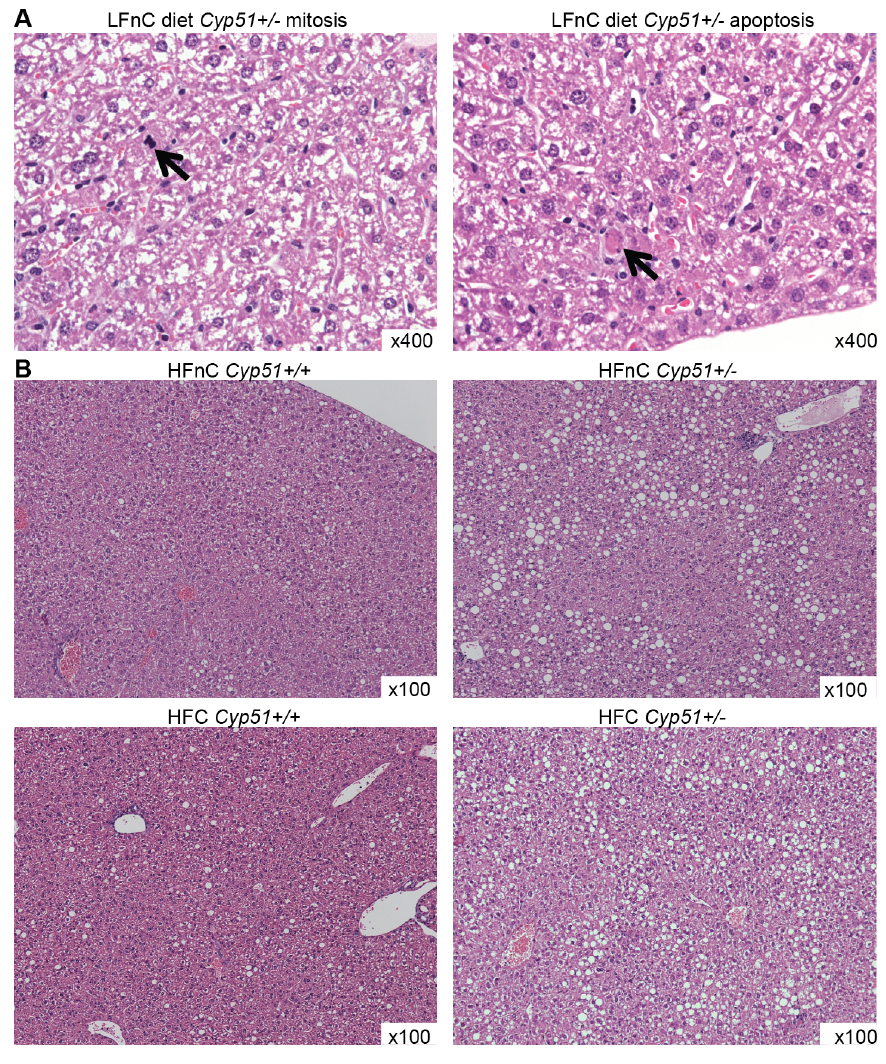
Figure 4. Liver histology, hematoxylin and eosin stain. A Mitotic (left) and apoptotic cells with hyper-eosinophilic cytoplasm containing fragments of dense basophilic nuclear material (right) in Cyp51 + / 2 mice on LFnC diet; original magnification x400. B Mild focal steatosis in Cyp51 + / + mice and moderate steatosis in Cyp51 + / 2 mice on HFnC and HFC diets; original magnification x100.